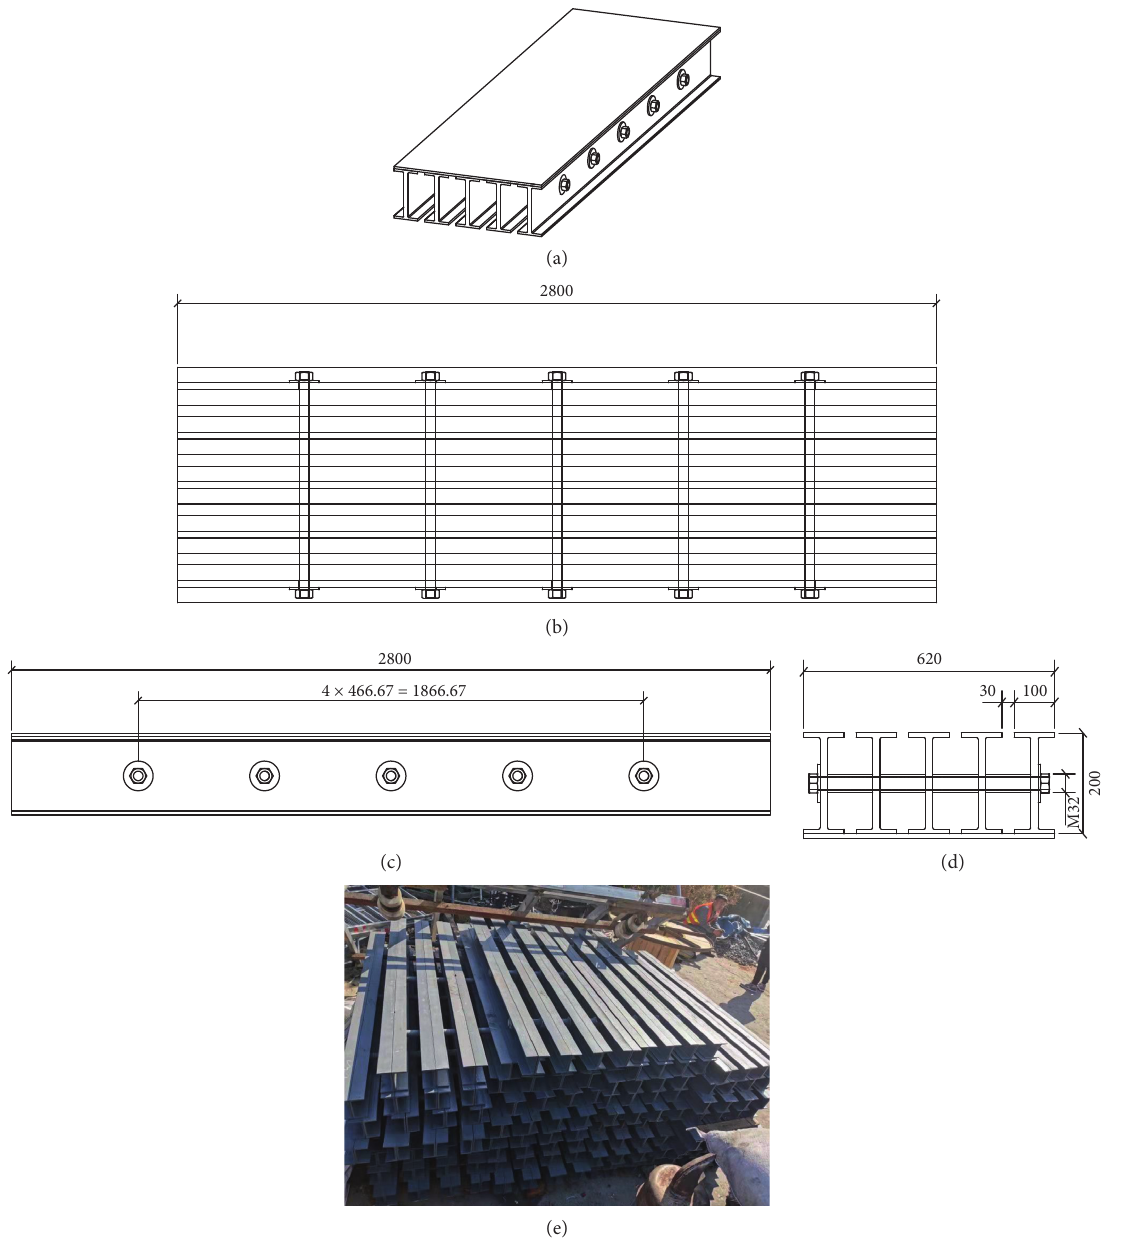
Figure 4: High-strength transverse diversion structure at the bottom of the tunnel. (a) 3D stereogram. (b) Top view. (c) Side view. (d) Section. (e) Physical